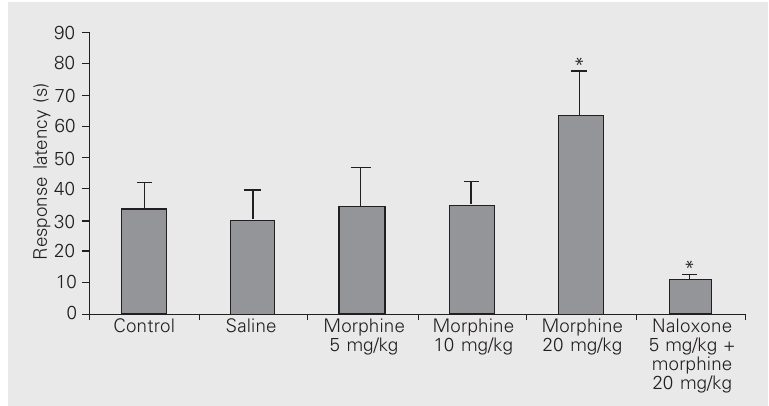
Figure 3. Effect of treatment with morphine, naloxone plus morphine, and saline (1.0 ml) on the response latency after thermal aversive stimuli (50 º C) 15 min after injection. Data are reported as means ± SEM for N = 9 animals in all groups. Note the significant difference between the group treated with 20.0 mg/kg body weight morphine and all other groups (P < 0.001), and the significant difference between the naloxone plus morphine-treated group and all other groups (P < 0.01). The vertical axis shows the response latency. *P < 0.01 (ANOVA followed by the Tukey test).